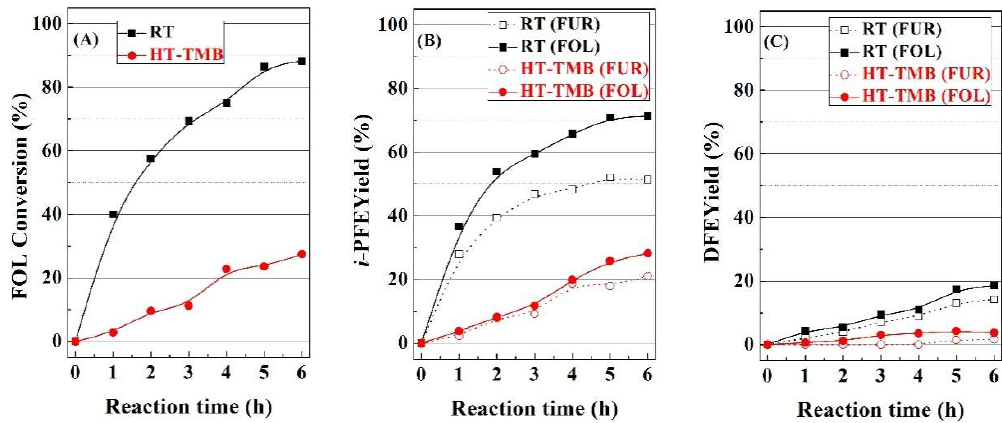
Figure 7. Furfuryl alcohol conversion ( A ), i -propyl furfuryl ether yield ( B ) and difurfuryl ether yield ( C ) in the MPV reaction using RT and HT-TMB catalysts. (Experimental conditions: 0.1 g of catalyst, reaction temperature: 110 ◦ C, i -POH/FOL molar ratio: 50, FOL/Catalyst mass ratio: 1). (In dashed lines, i -PFE and DFE yields using FUR as